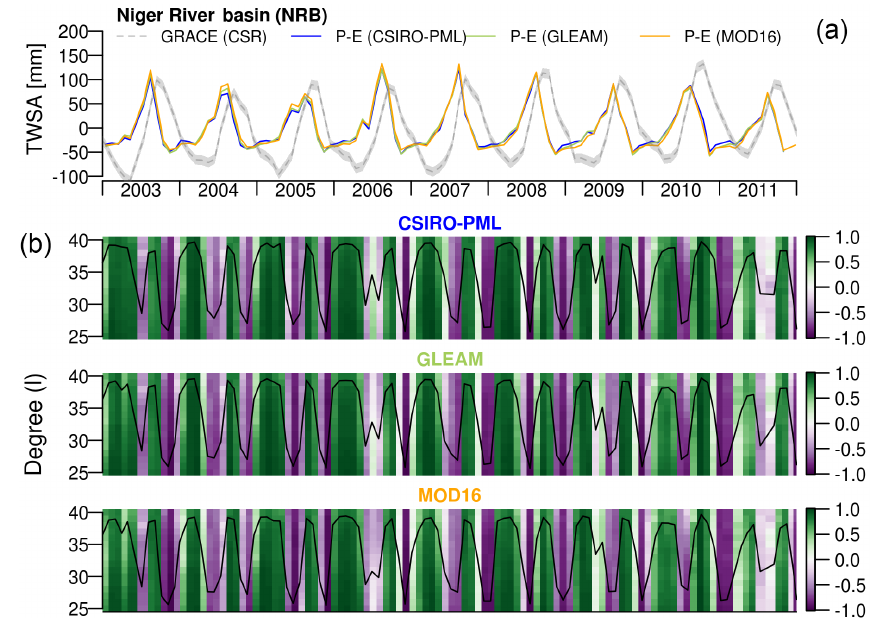
Figure 5. Top: anomalies of the terrestrial water storage (TWSA) observed by GRACE (with 20mm uncertainty bounds) and P − E using three global evaporation products over the Niger River basin. Below: varying degree correlation measure ( r l ) with time and degree (from 25 to 40) using the three global evaporation products. The average r l is shown as a time series (black line). The degree correlation measure can range from − 1 to 1, as shown in the colour scale on the secondary